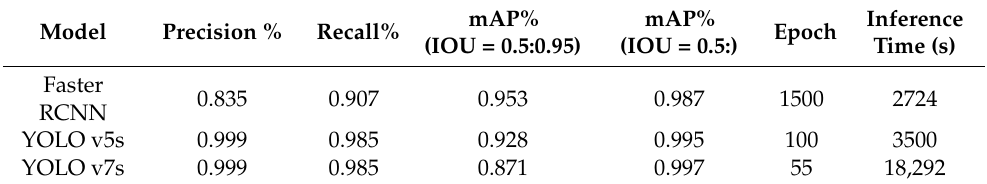
Table 6. A comparison with the state-of-the-art one-stage detector. Model